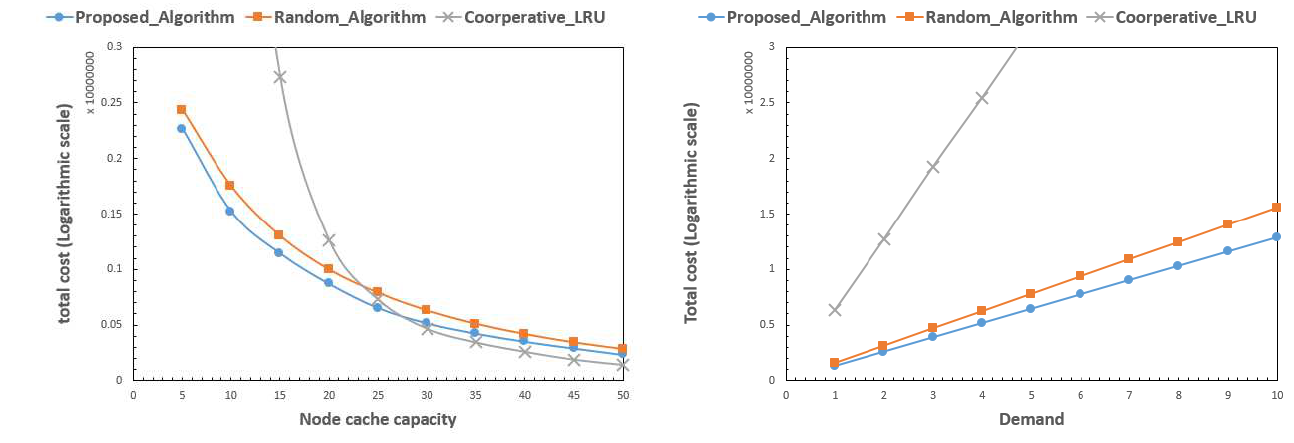
Figure 3. E˙ect of nodecapacity. Figure 4. E˙ect of data demand.